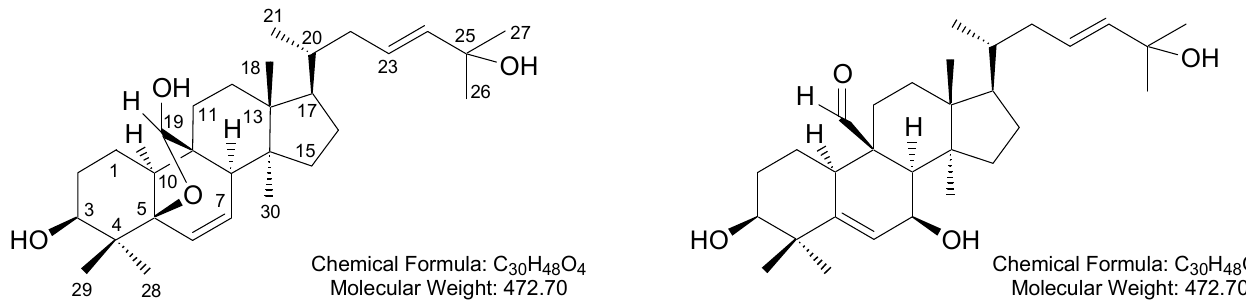
Figure 1. Chemical structures of 5 β ,19-epoxycucurbita-6,23-dien-3 β ,19,25-triol (Kuguacin R; KR) and 3 β ,7 β ,25-trihydroxycucurbita-5,23-dien-19-al (TCD).